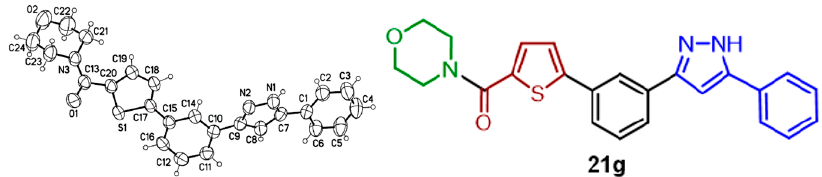
Figure 2. ORTEP diagram of compound 21g (on the left side) obtained by X-ray analysis.